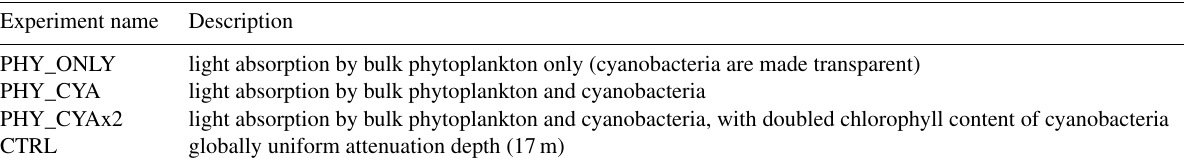
Table 1. Experiment names and